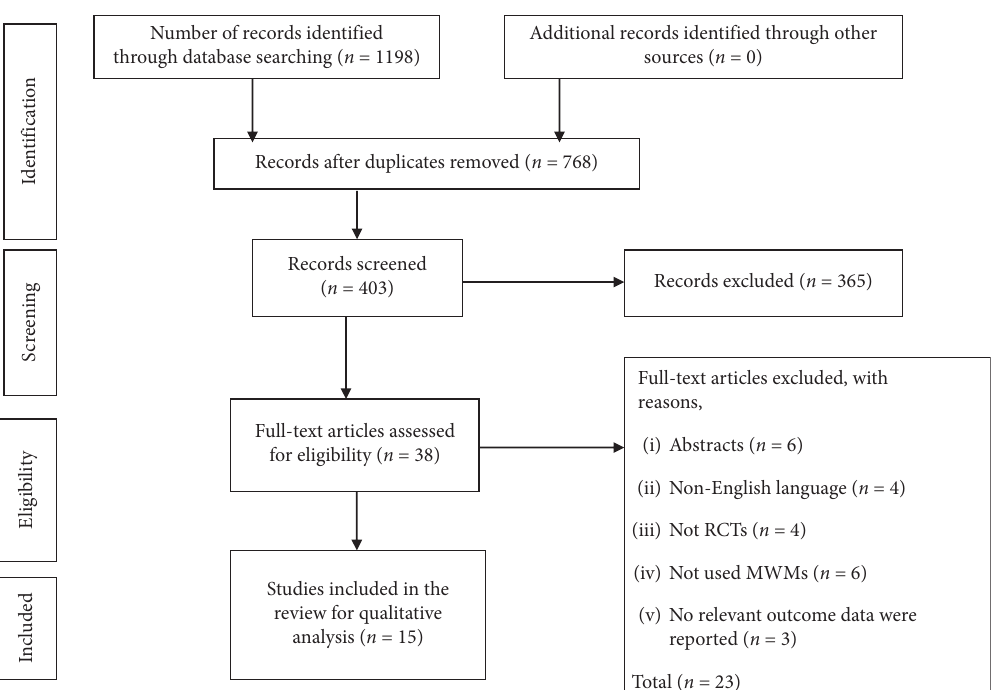
Figure 1: PRISMA flowchart of the